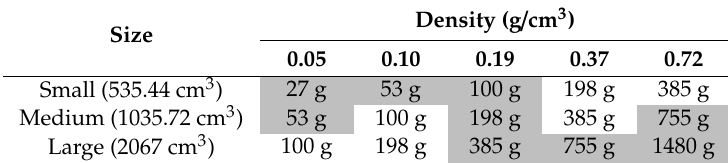
Table 11. Weight conditions for box